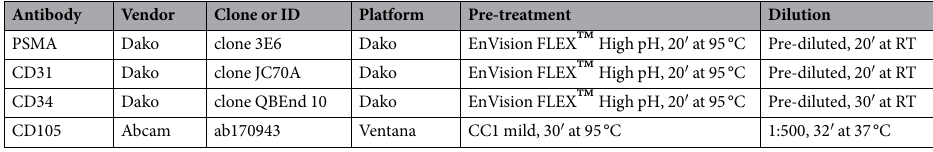
Table 4. Antibodies used in the